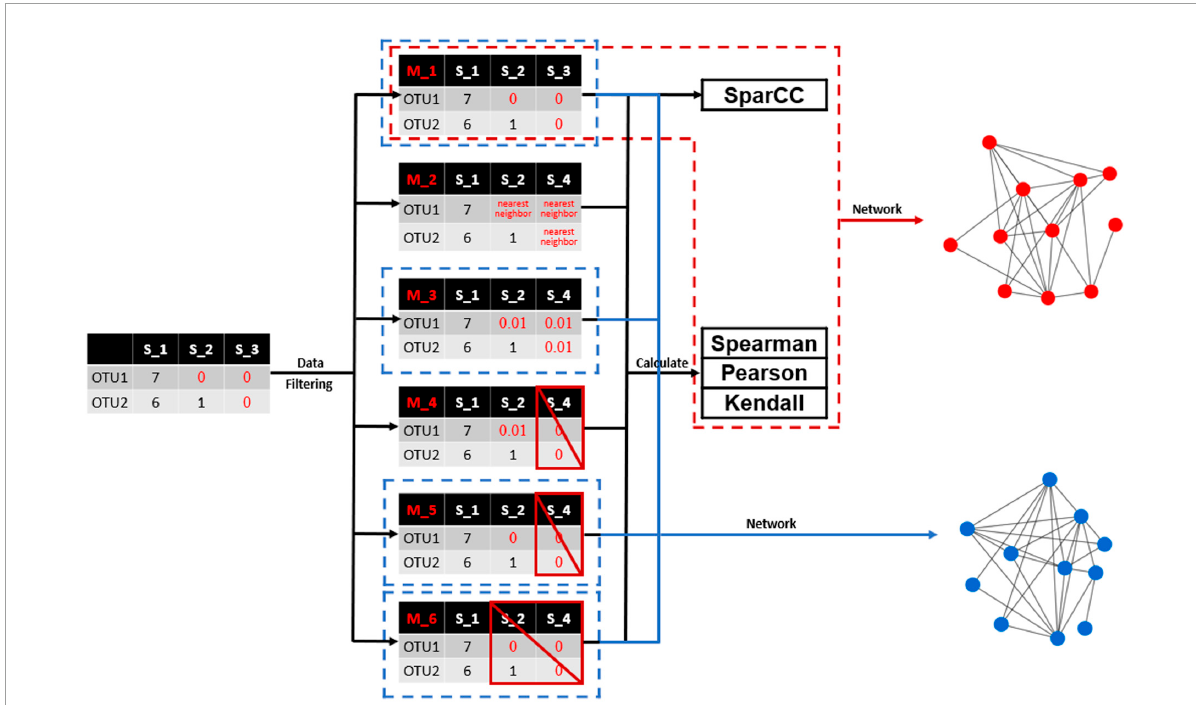
FIGURE1 A flowchart illustrating the overall methodology workflow of this study. A typical microbial profile containing large number of missing values was selected as the example dataset. Different data filtering methods were then applied to process the missing values associated with the microbial profile. Commonly used correlation coefficient calculation methods including the SparCC, Spearman, Pearson, and Kendall were applied to calculate the pairwise correlation among microbial taxa. Association networks were then constructed and comparatively